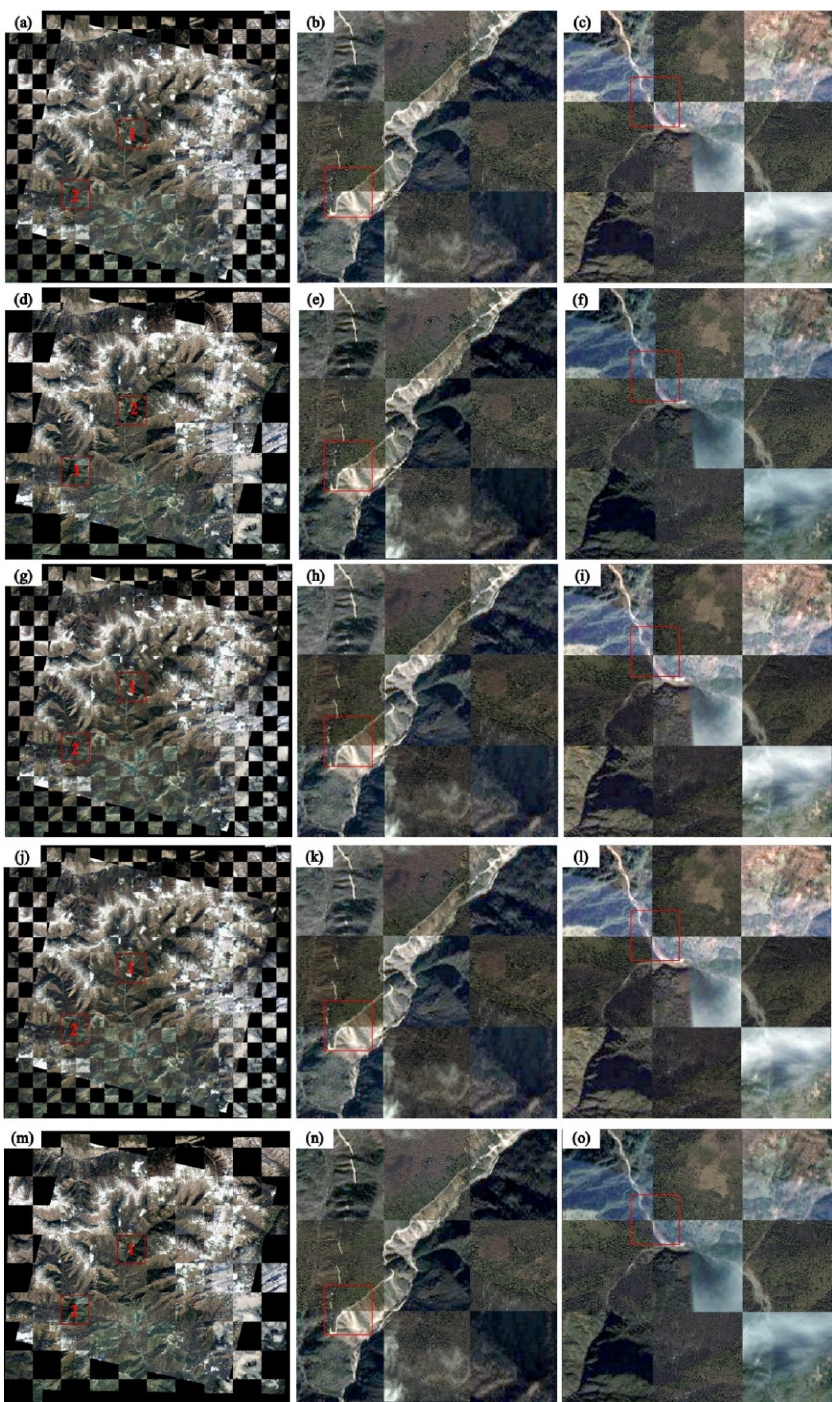
Figure 10. Checkerboard images for the P-B dataset. ( a ) Original image; ( b ) enlarged image of red box 1 in ( a ); ( c ) enlarged image of red box 2 in ( a ); ( d ) result for the proposed method; ( e ) enlarged image of red box 1 in ( d ); ( f ) enlarged image of red box 2 in ( d ); ( g ) result for the Patch-SIFT; ( h ) enlarged image of red box 1 in ( g ); ( i ) enlarged image of red box 2 in ( g ); ( j ) result for the SIFT; ( k ) enlarged image of red box 1 in ( j ); ( l ) enlarged image of red box 2 in ( j ); and ( m ) result for the SURF; ( n ) en- larged image of red box 1 in ( m ); ( o ) enlarged image of red box 2 in ( m ). The red boxes indicate the regions where noticeable differences can be observed.